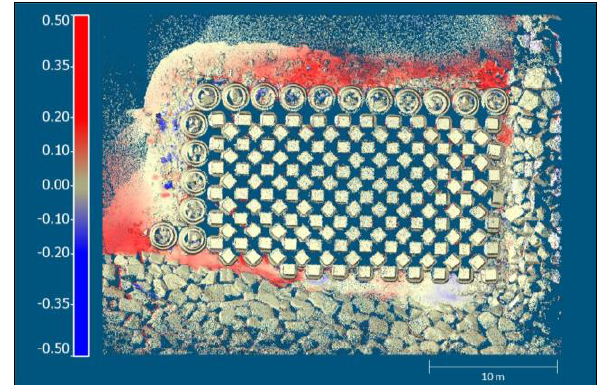
Figure 9. April / May differences [m]